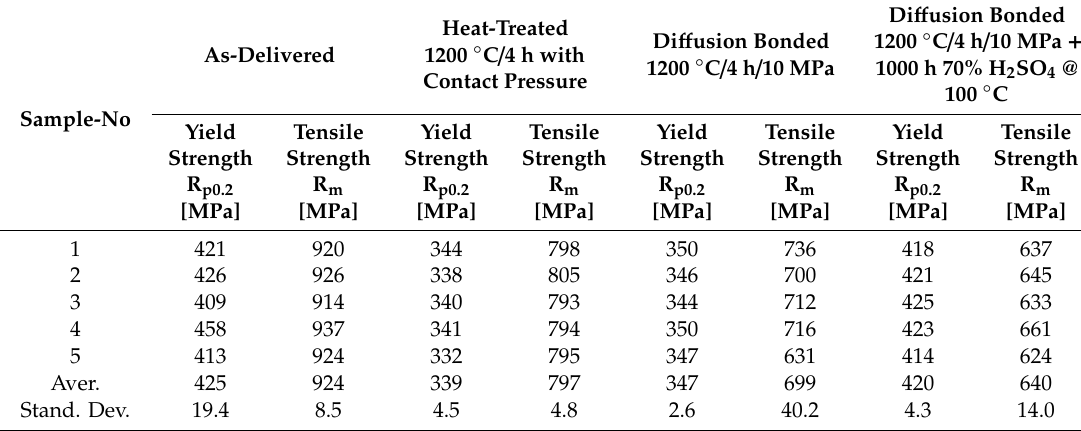
Table 6. Mechanical properties of Hastelloy B3 tested in di ff erent conditions. ( A ) Yield strength and tensile